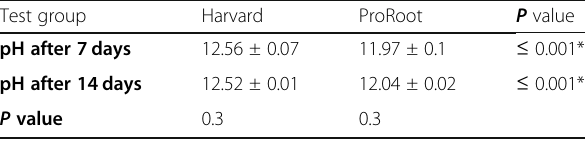
Table 2 Means and standard deviations of pH values after 7 and 14 days for the two tested cements stored in distilled water Test group Harvard ProRoot